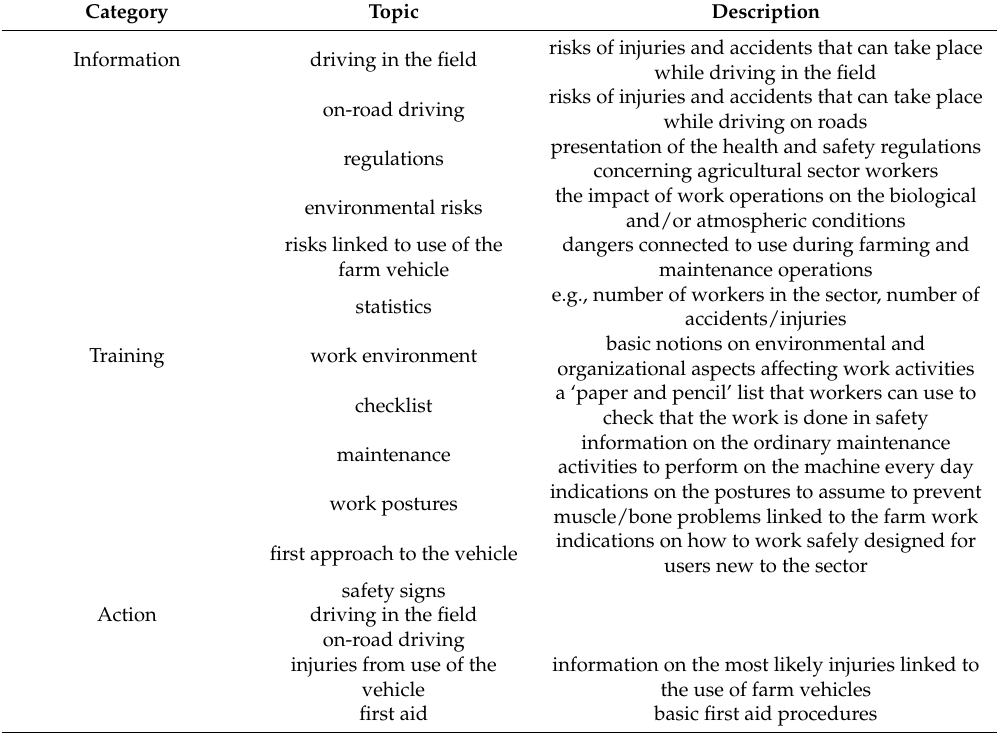
Table 1. The categories and the relevant topics proposed to the participants of the focus